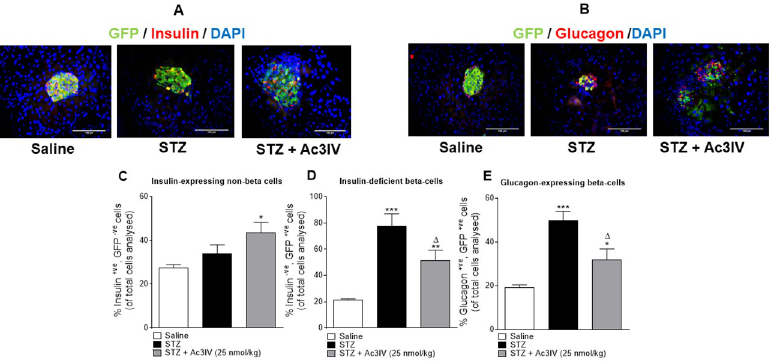
Fig 4. Effects of Ac3IV treatment on pancreatic islet cell lineage in STZ-diabetic Ins1Cre /+ Rosa26-eYFP mice. Parameters were assessed following 12 days twice-daily treatment with saline (0.9% NaCl) vehicle or Ac3IV (25 nmol/ kg bw, i.p.) in STZ-diabetic Ins1Cre /+ Rosa26-eYFP transgenic mice. Representative images (40X) of pancreatic islets depicting co-localisation of GFP (green) with either insulin or glucagon (red) are shown in panels (A&B). Numbers of insulin +ve , GFP -ve (C), insulin -ve , GFP +ve (D) and glucagon +ve , GFP +ve (E) islet stained cells were assessed utilising the cell counting function within Cell F imaging software. Values are mean ± SEM for n = 6 mice. � p < 0.05, �� p < 0.01, ��� p < 0.001 compared to saline vehicle. Δ p < 0.05 compared to STZ-diabetic controls.